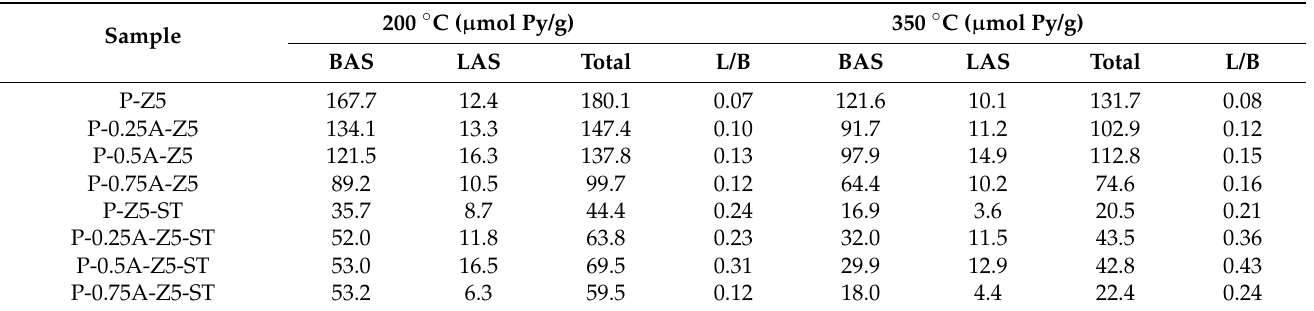
Table 4. Acidity and its acidic-site distributions of the P-xA-Z5 and P-xA-Z5-ST samples according to Py-IR measurement.